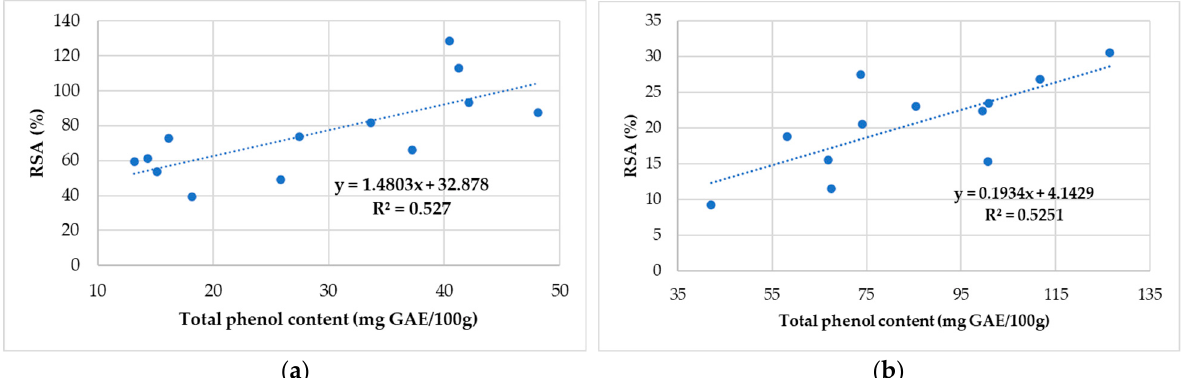
Figure 4. Correlation between antioxidant activity and total phenolic content of the honey sample collected ( a ) from North-West and Central Romania and ( b ) from Alba County.